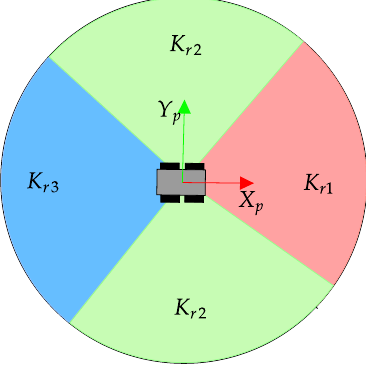
Figure 9. Possible values for the K r parameter.